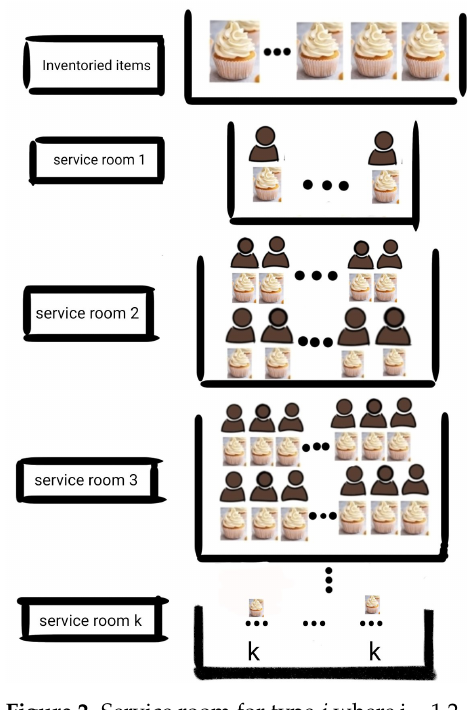
Figure 2. Service room for type j where j =